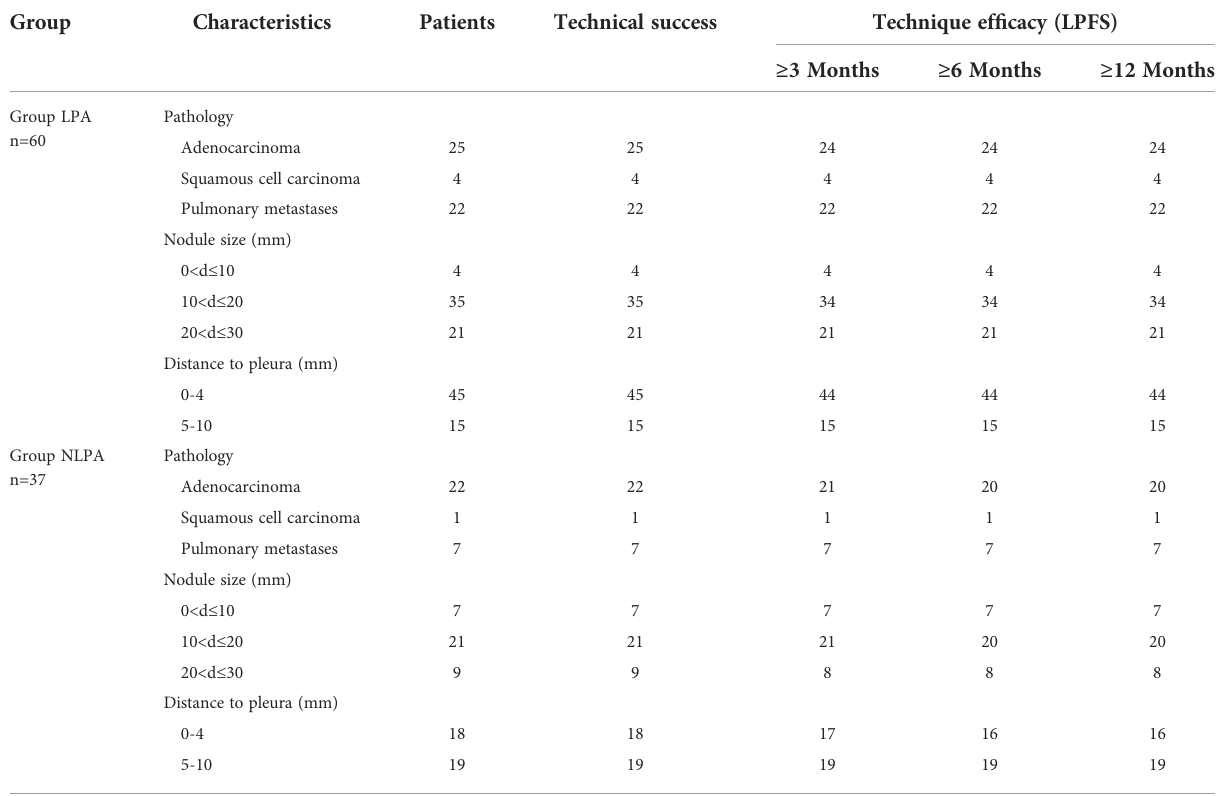
TABLE 2 Technique ef fi cacy and follow-up of LPFS. Group Characteristics Patients Technical success Technique ef fi cacy (LPFS)